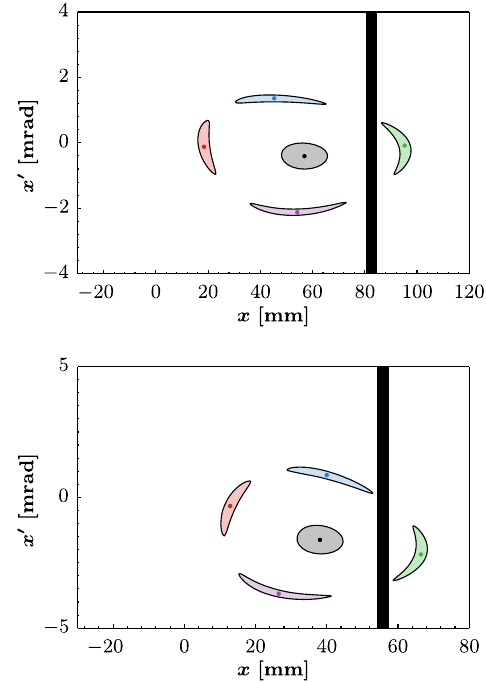
is MTE FIG. 20. Horizontal phase space portraits at TPS15 (top) and SMH16 (bottom) during the fast extraction bump. The shown surfaces of the islands represent single particle 2D tracking results, for a particle situated close to the separatrix. The optimization of the rotation has to consider the phase advance of ≈ 22 . 5 ° between the two